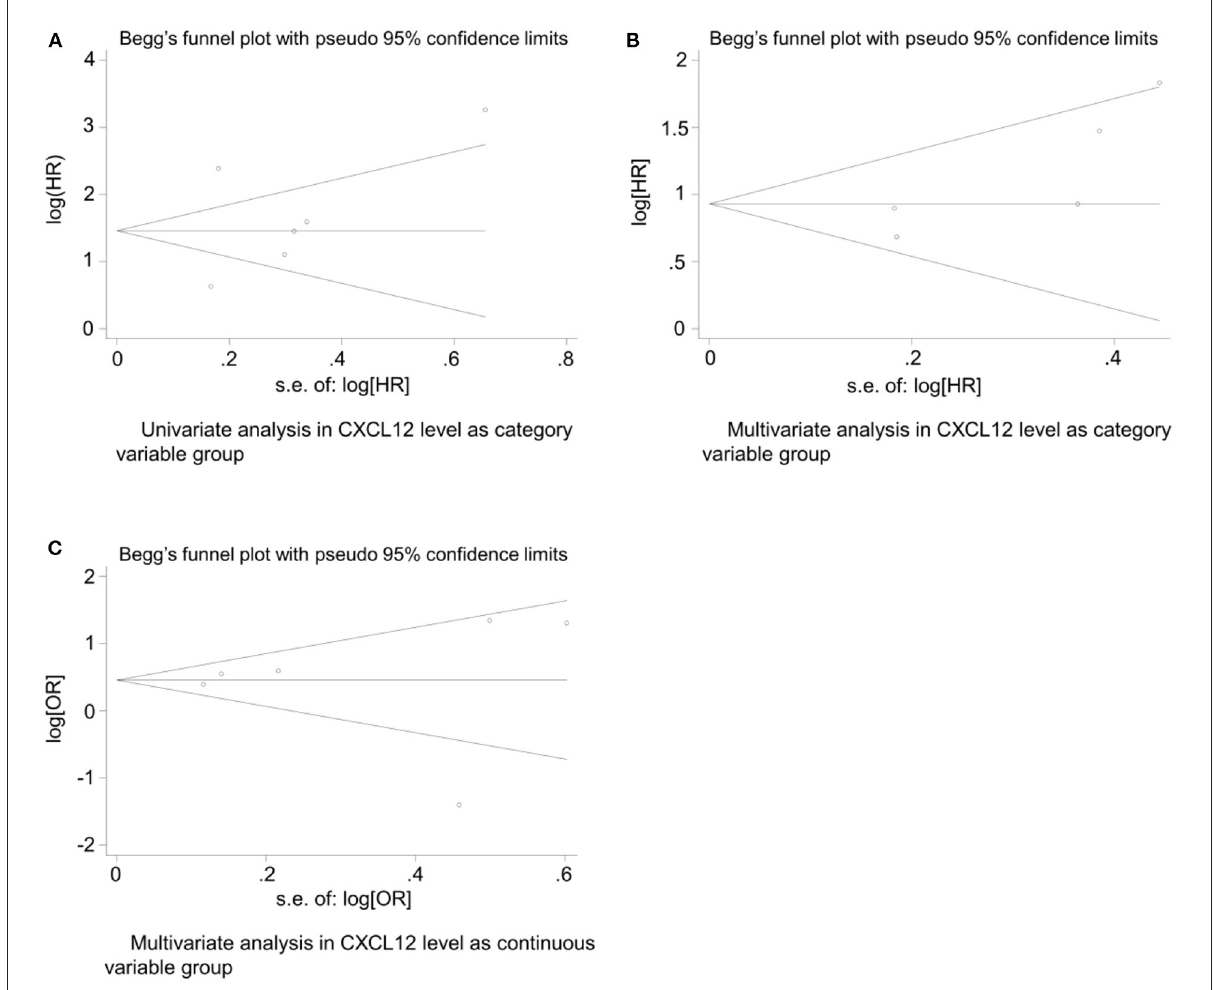
FIGURE5 Begg’s funnel plot for evaluating publication bias of included studies. (A) Univariate analysis in CXCL12 level as category variable group ( Z = 1.13, P = 0.26); (B) multivariate analysis in CXCL12 level as category variable group ( Z = 1.71, P = 0.086); (C) and multivariate analysis in CXCL12 level as continuous variable group ( Z = 0.75, P =